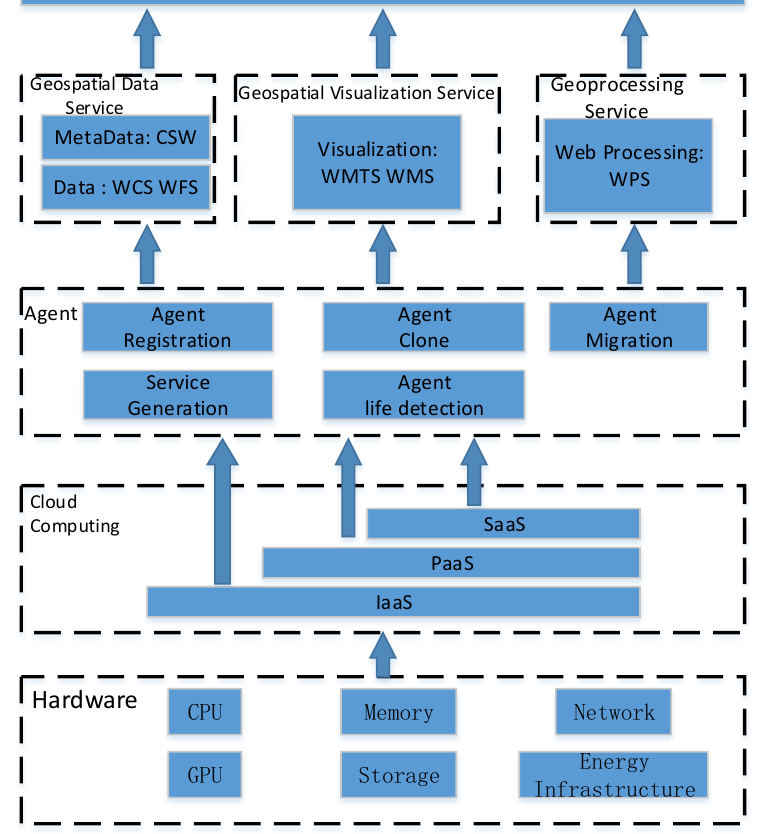
Figure 2 Agent- and Cloud-supported Geospatial Service Aggregation